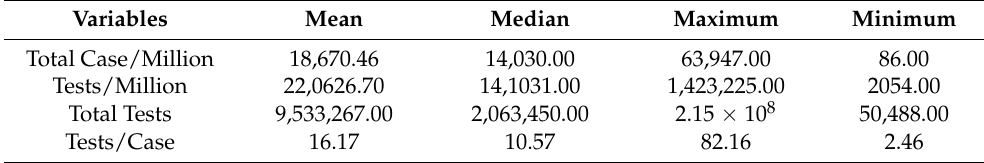
Table 2. Descriptive statistics of the